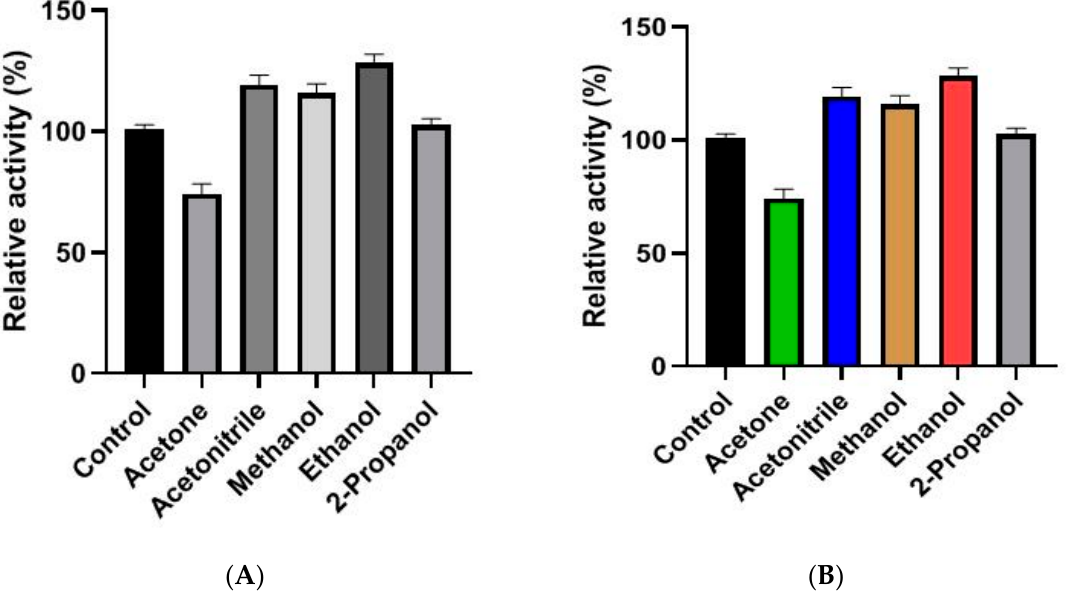
Figure 4. Effect of organic solvents on DrPLA 2 -Vstability. Enzyme was incubated with the appro- priate agent for 1 h ( A ) and 2 h ( B ) and the remaining phospholipase activity was tested at the optimal